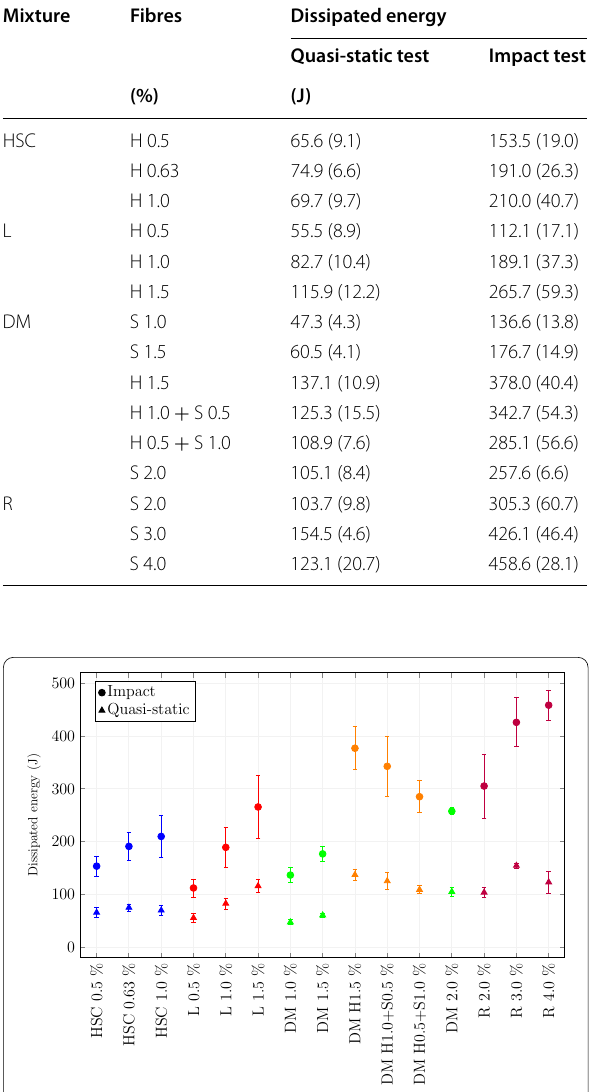
Fig. 12 Dissipated energies for the quasi-static and impact